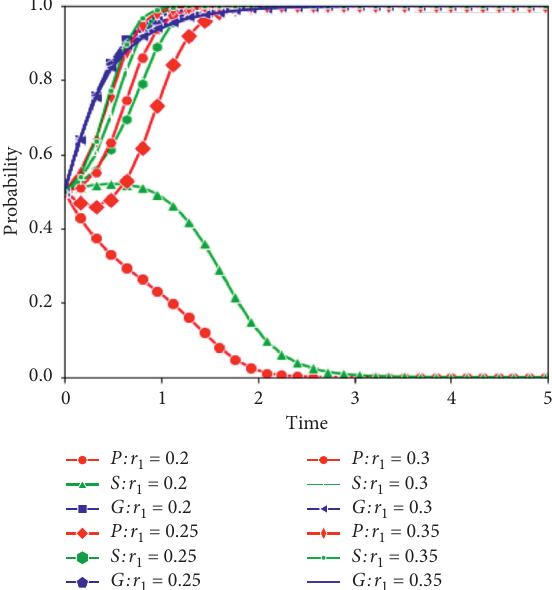
Figure 8: Dynamic evolution process of the tripartite game sub- in the figure) jects when r ′ ( r ′ is replaced by r 1